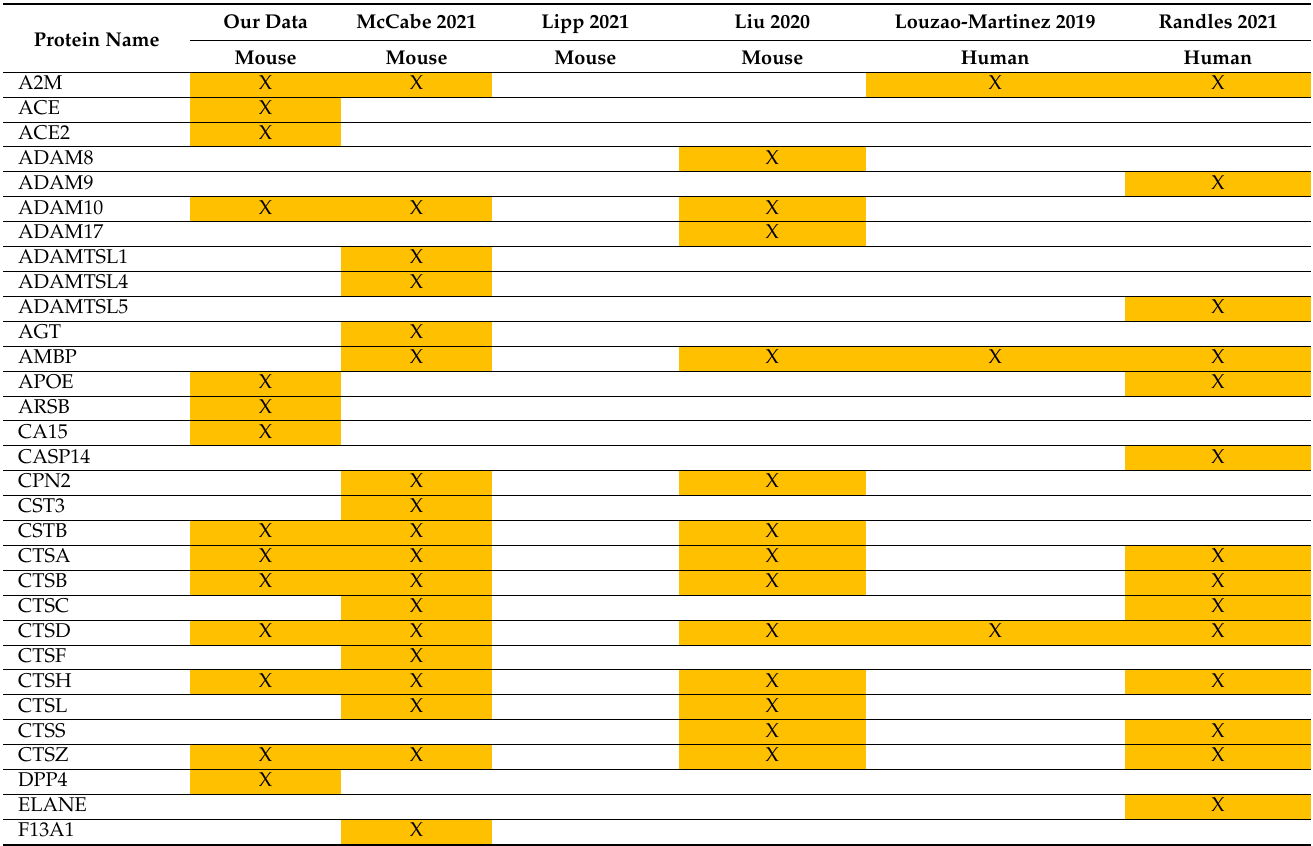
Table A13. The combined list of matrisome-associated proteins belonging to the category of ECM regulators and identified in mouse and human kidneys. The mouse matrisome proteins were obtained from our data and extracted from references [20,28,30]. Human matrisome proteins were obtained from the studies [31,32]. Highlighted “X” refers to identified protein in the corresponding